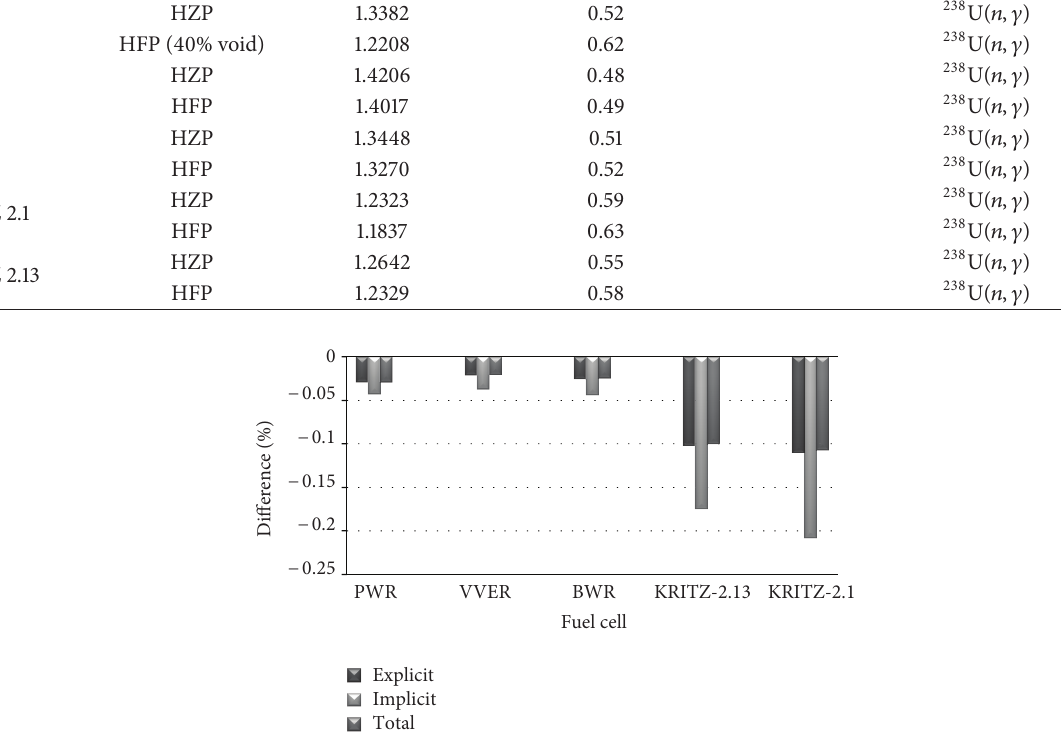
Figure 2: Relative change in the sensitivity of 238 U( 𝑛,𝛾